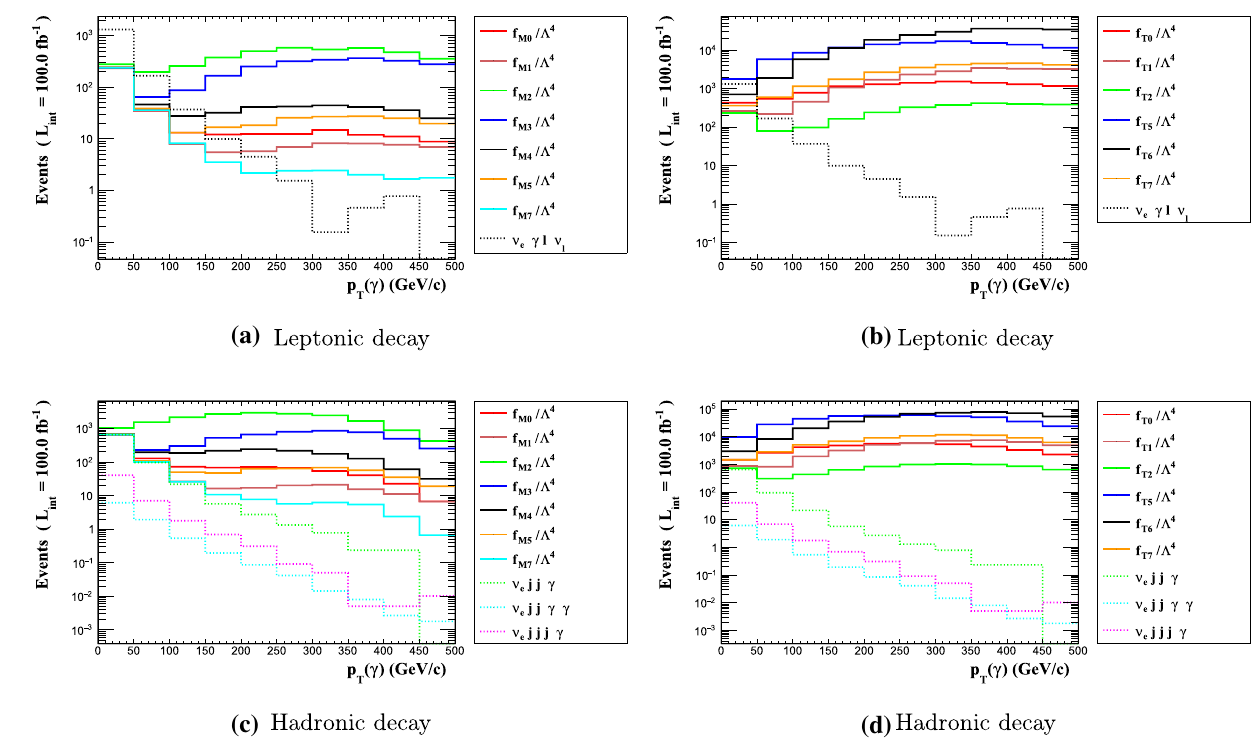
γ Fig. 11 The number of expected events as a function of the p f M , i /(cid:4) 4 with i = 0 , 1 , 2 , 3 , 4 , 5 , 7 , f T , j /(cid:4) 4 with j = 0 , 1 , 2 , 5 , 6 , 7 photon T transverse momentum for the e − p → e − γ ∗ p → pW − γν e signal and and various backgrounds for both leptonic and hadronic decay channel √ s = 1 . 98TeV.Thedistributionsarefor of the W backgroundsattheLHeCwith